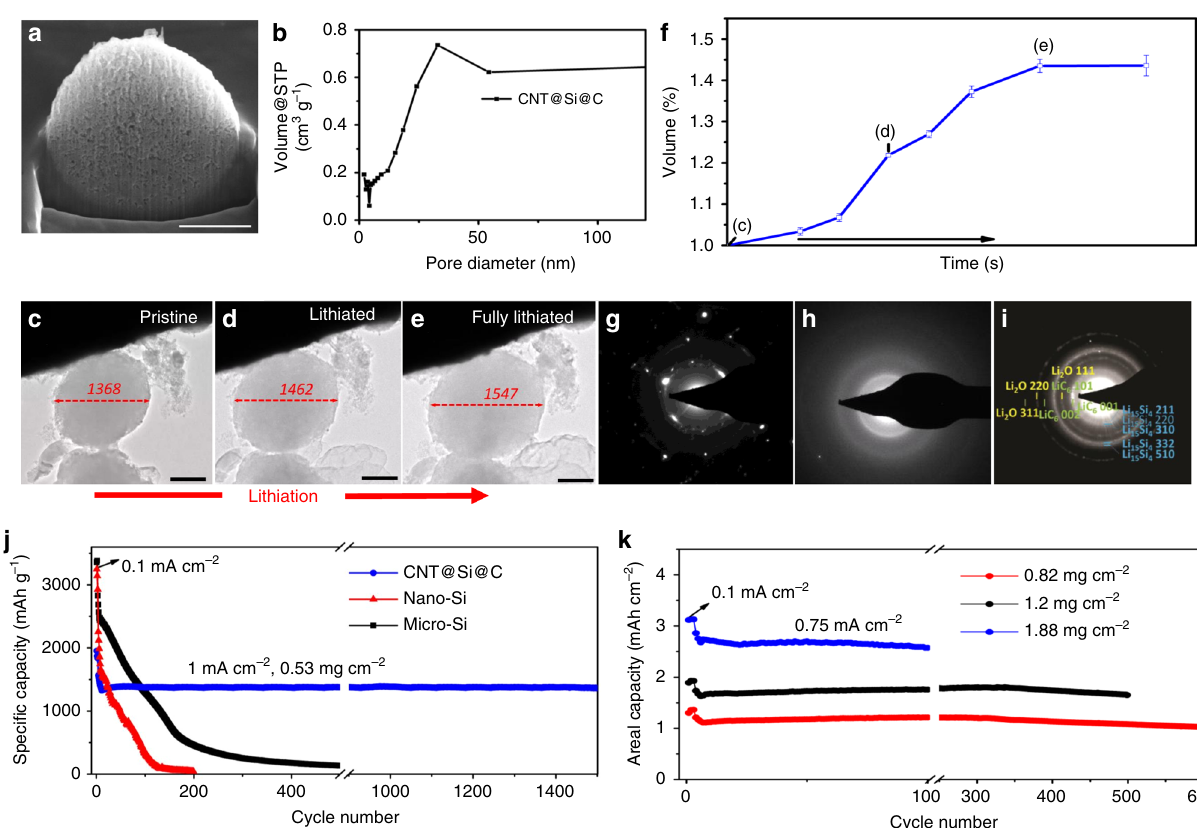
Fig. 2 Characterization of the CNT@Si@C porous structure, particle swelling, and electrochemical performance. a Cross-section SEM of a typical CNT@Si@C microsphere (scale bar = 1 µ m). b Pore diameter distribution of CNT@Si@C from gas absorption. c – e In-situ TEM images of a CNT@Si@C particle at different lithiation states (scale bar = 0.5 µ m). The unit of the numbers in fi gures is nm. f Volume expansion curve of the particle recorded during the lithiation process. g – h The selected area electron diffraction (SAED) patterns of CNT@Si@C at different lithiation states. j Long-term cycling